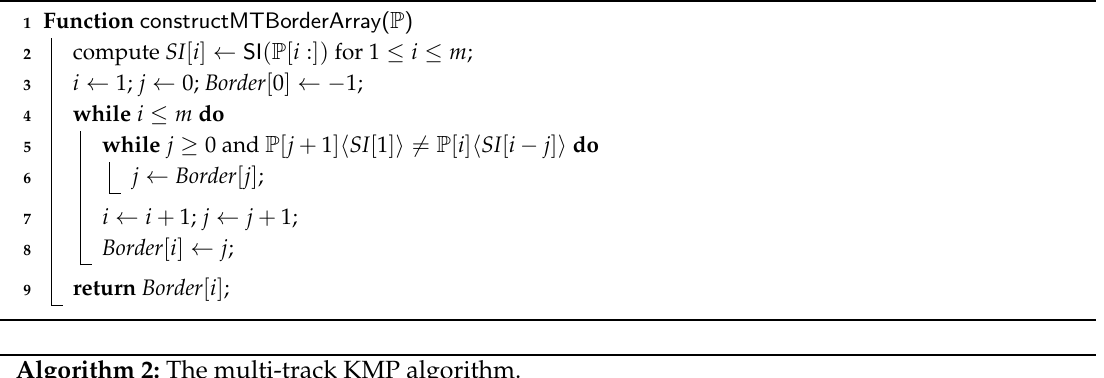
Algorithm 2: The multi-track KMP